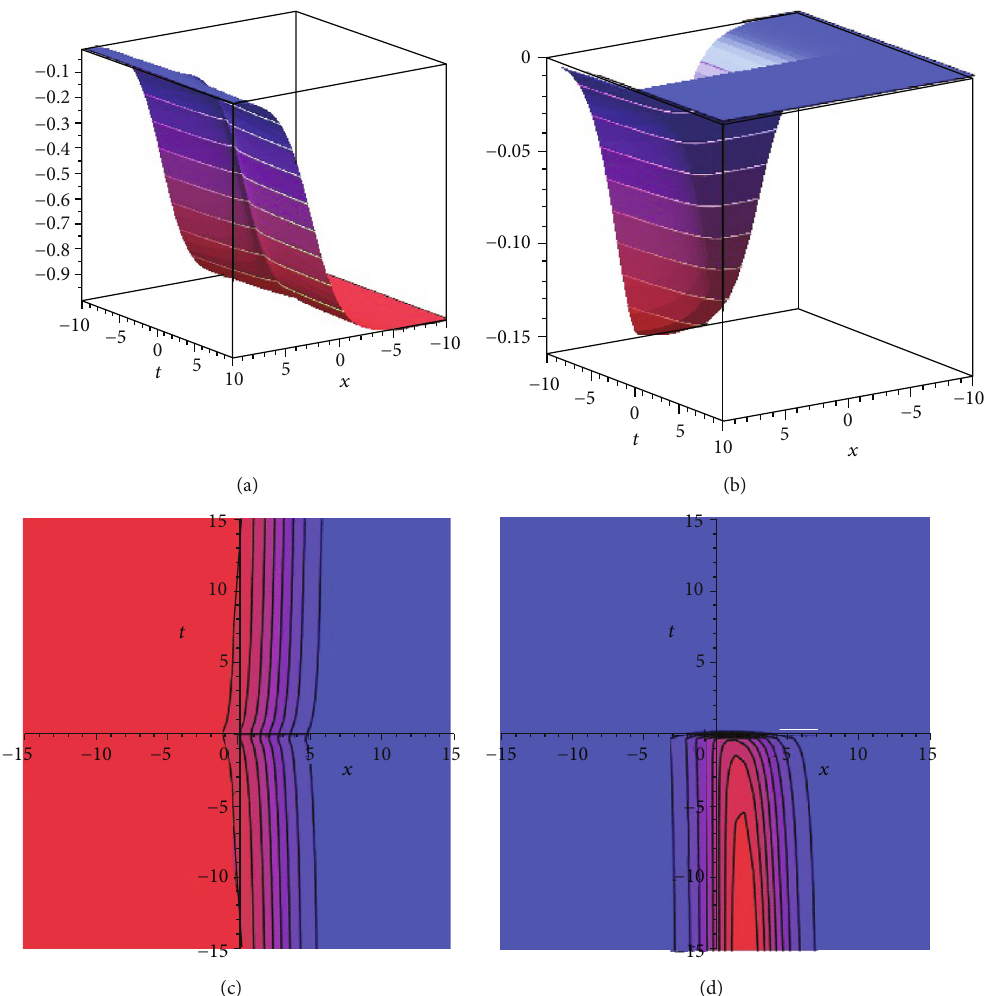
ð x , t Þ : (a) real three-dimensional shape, (b) complex three-dimensional shape, (c) 10